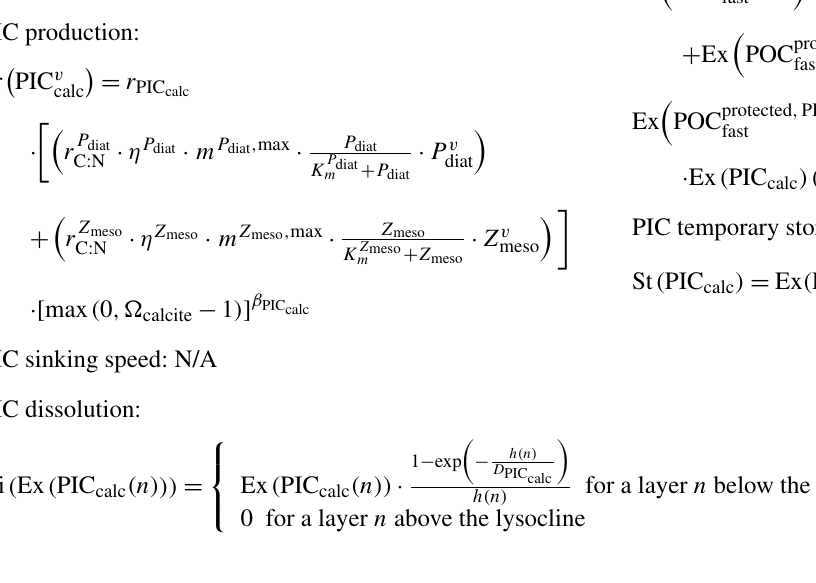
Table C11. MEDUSA-2.1